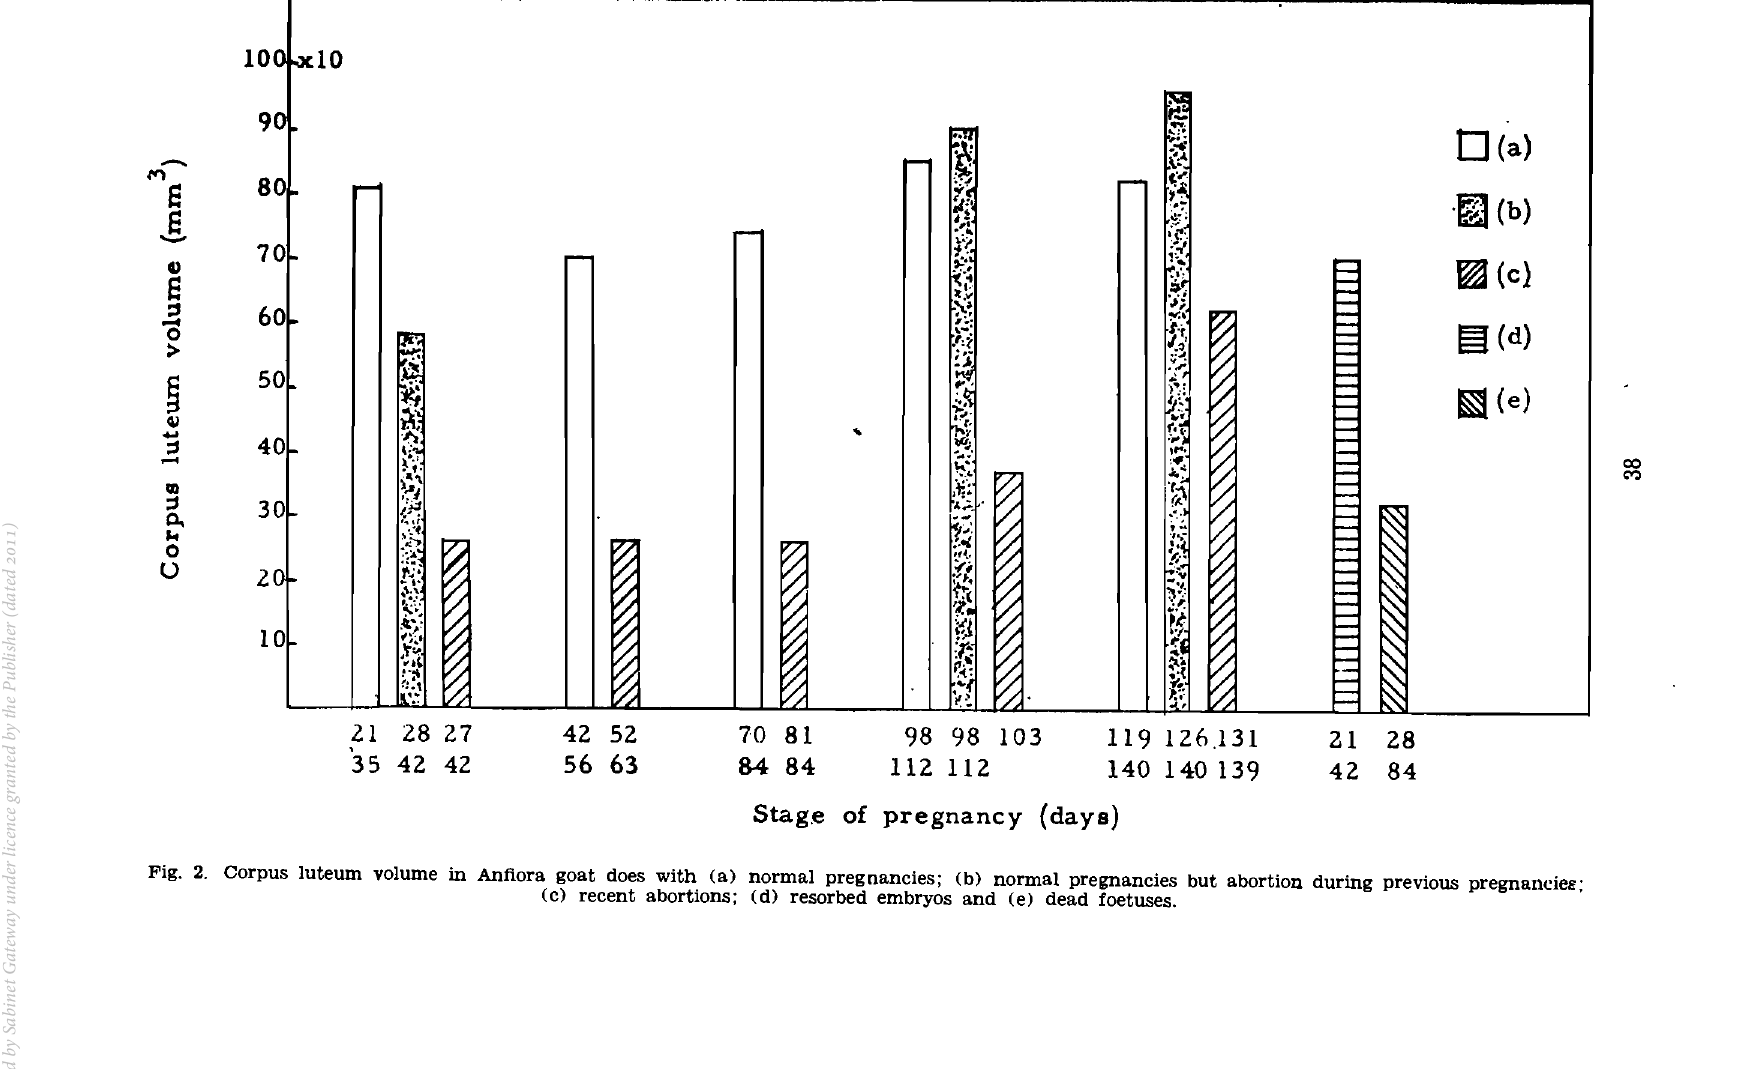
Fig. 2. Corpus luteum volume in Anfiora goat does with (a) normal pregnancies; (b) normal pregnancies but abortion during previous pregnancieli'; (c) recent abortions; (d) resorbed embryos and (e) dead